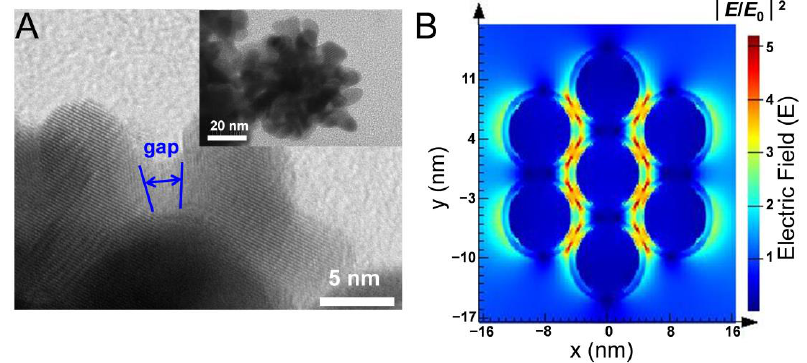
Figure 3. ( A ) TEM images and ( B ) electric field by FDTD simulation of the pAuNCs. To verify the feasibility of the prepared pAuNCs as SERS tags for quantitative im- munoassays, SERS spectra of pAuNCs in different concentrations were recorded and shown in Figure 4A. For the concentration of pAuNCs ranging from 0.001 to 10.0 mg L −1 , the intensity of SERS peaks increased with higher amounts of SERS tags. The Raman peaks of pAuNCs at 518, 1168, and 1661 cm −1 show an obvious upward tendency along with the increased pAuNCs concentrations (Figure 4B). Meanwhile, a reasonable corre- sponding relationship was observed between the pAuNCs concentration and the inten- sity of the peak at 1168 cm −1 with a correlation coefficient (R 2 ) of 0.982 (Figure S7 of the